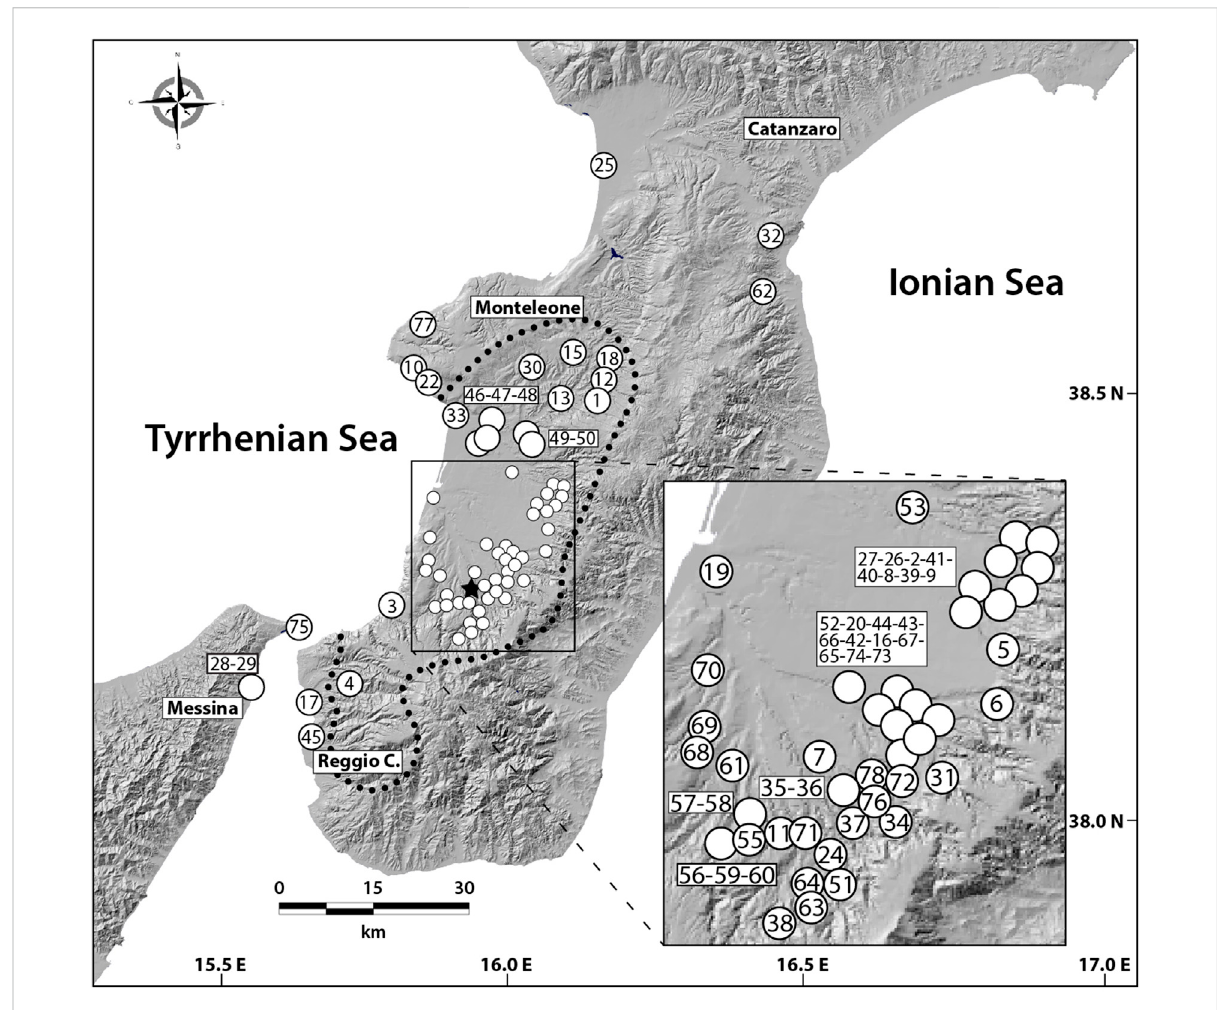
FIGURE 5 Distribution of the hydrological anomalies (white circles) associated with the 5 February 1783 earthquake. Numbers inside the circles correspond to therecords inTable 2.Observation n. 21 islocated outside themap. Dotted line encloses theareaof heavy destruction (Int > 9MCS). A black sar marks the location of the epicenter of the